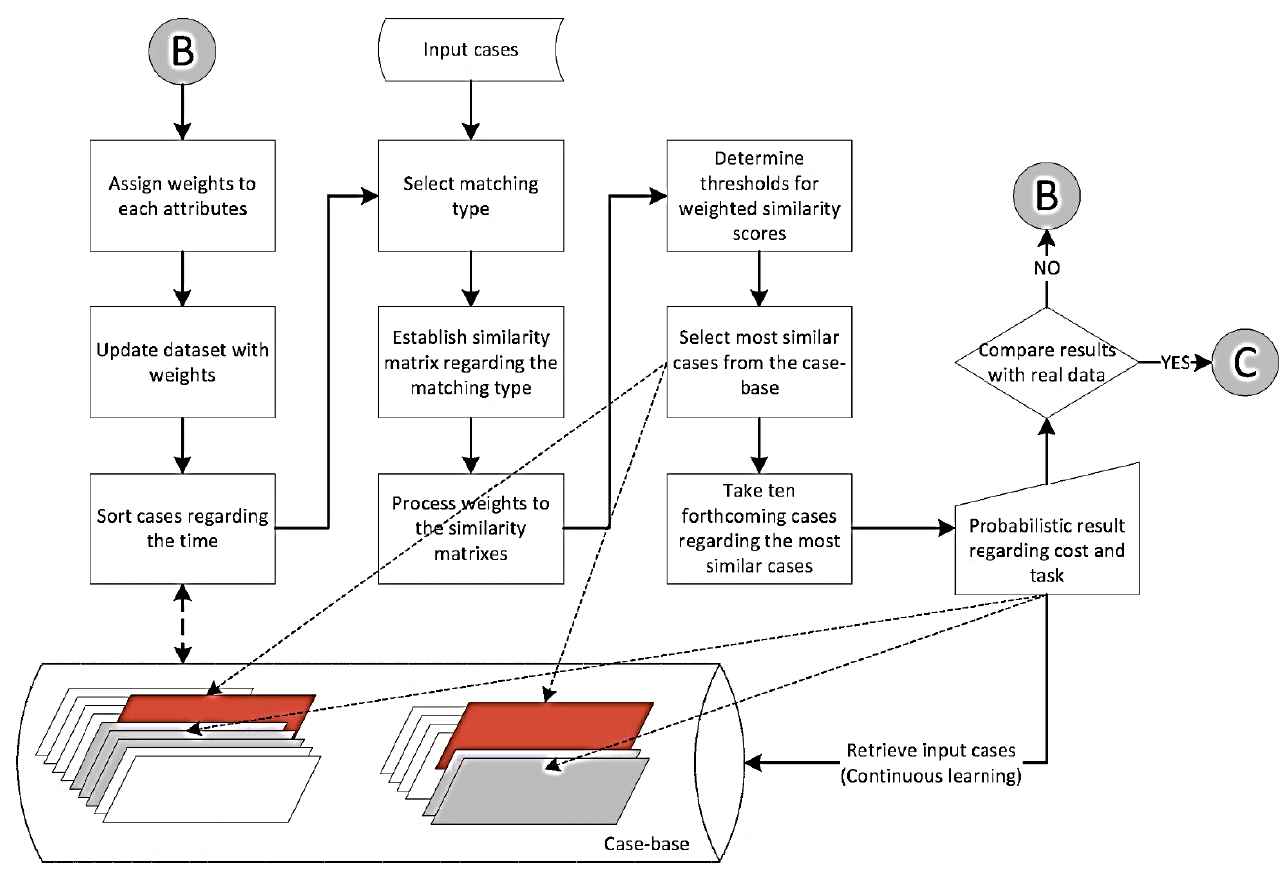
Figure 6. Steps followed in CBR [59] .